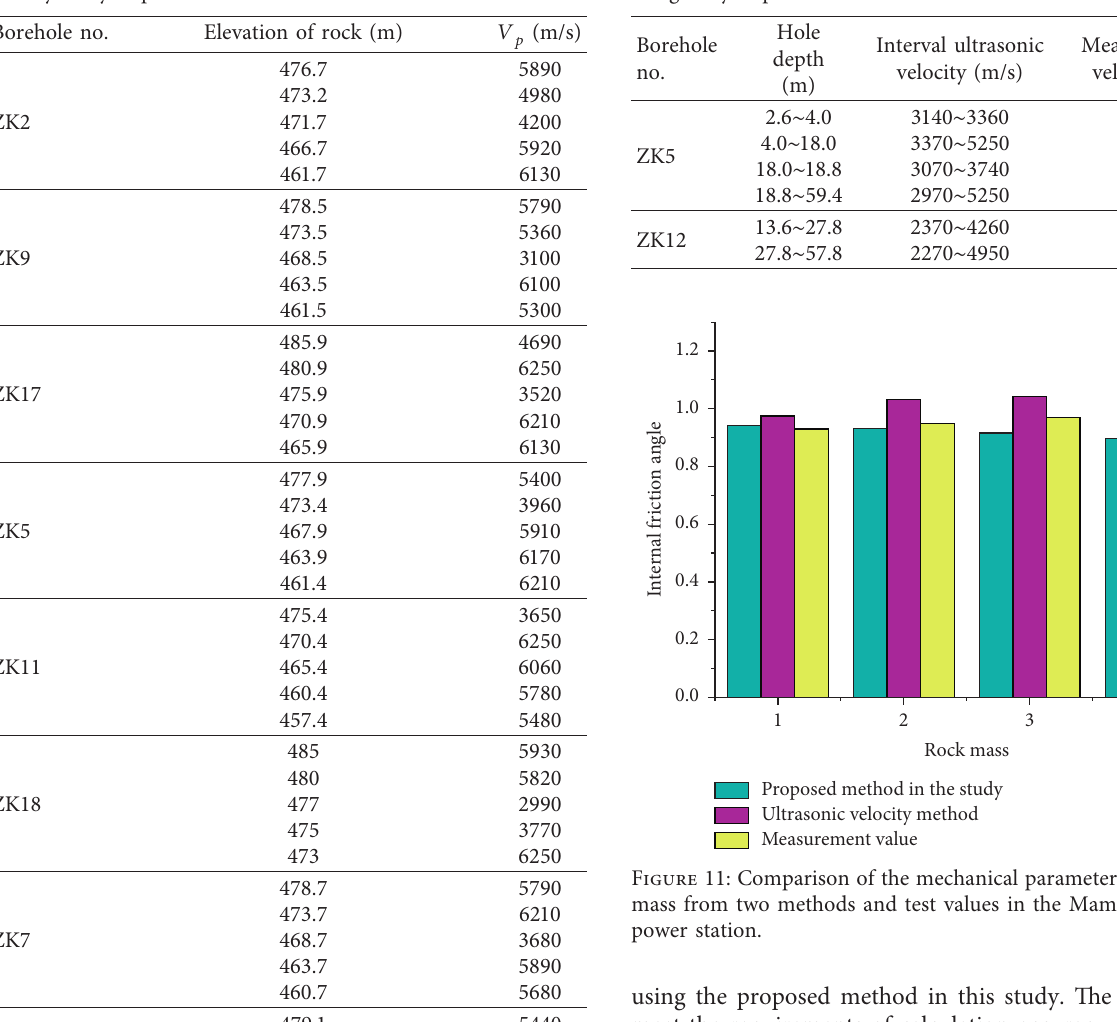
Table 4: The ultrasonic velocity values of the rock mass in the Ronglai hydropower station.